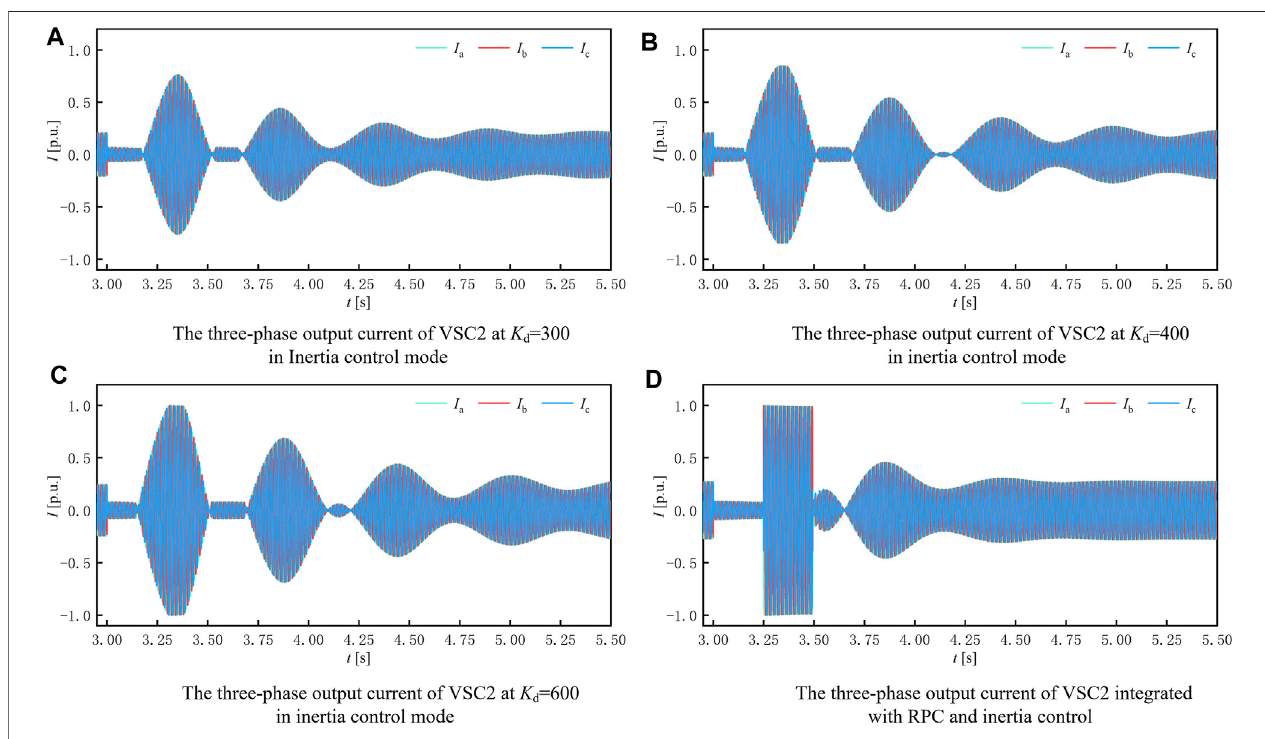
FIGURE 12 | Three-phase output current of VSC2 under different inertia control modes.